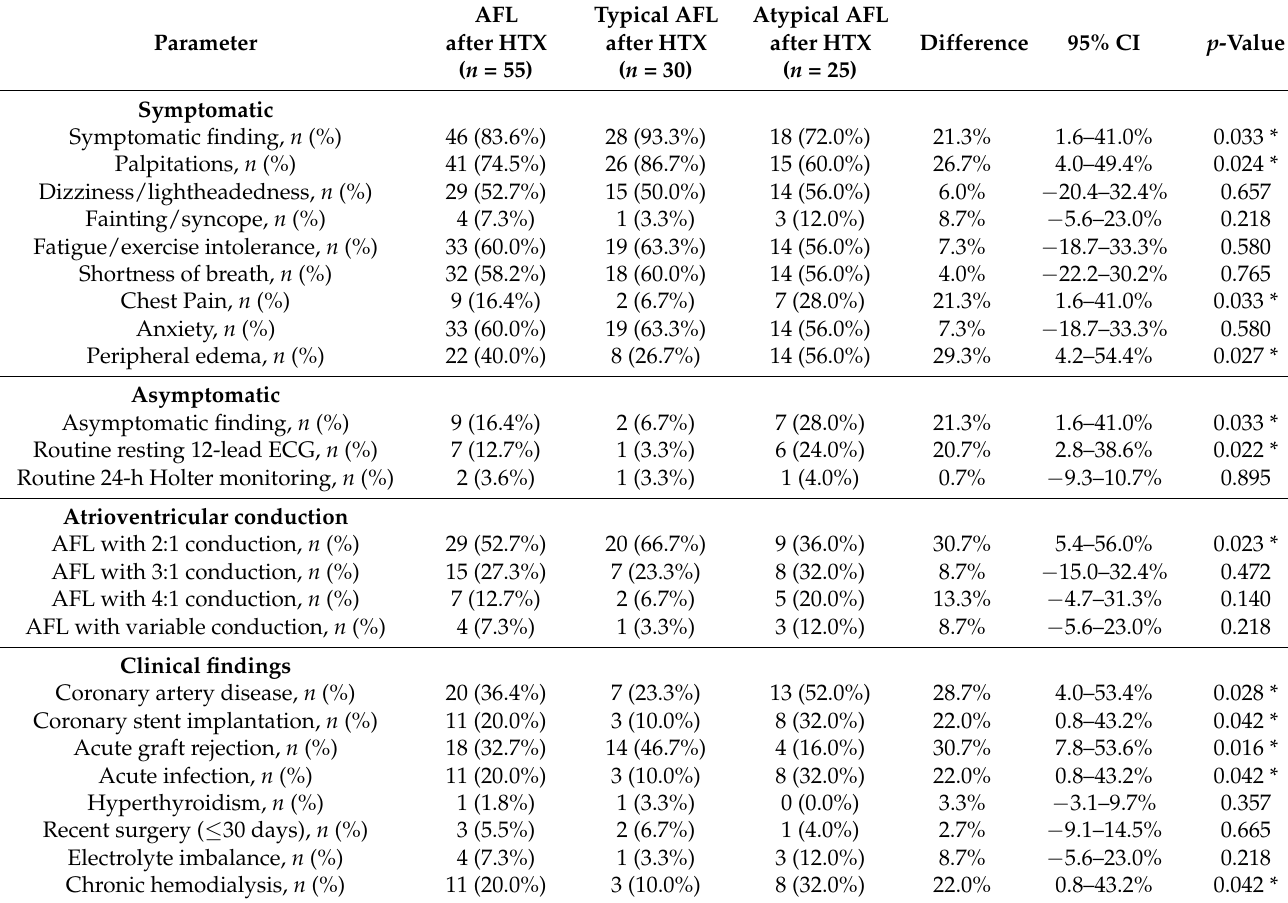
Table 5. Clinical presentation and findings of patients with late-onset AFL after